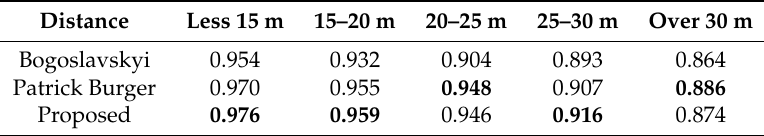
Table 3. The scene accuracy of different methods at different